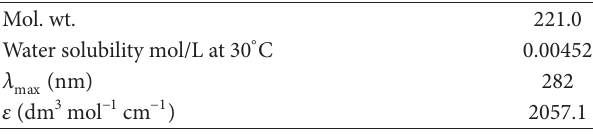
T 2: Physico-chemical properties of adsorbate 2, 4-Dichlo- rophenoxyacetic acid (2, 4-D).